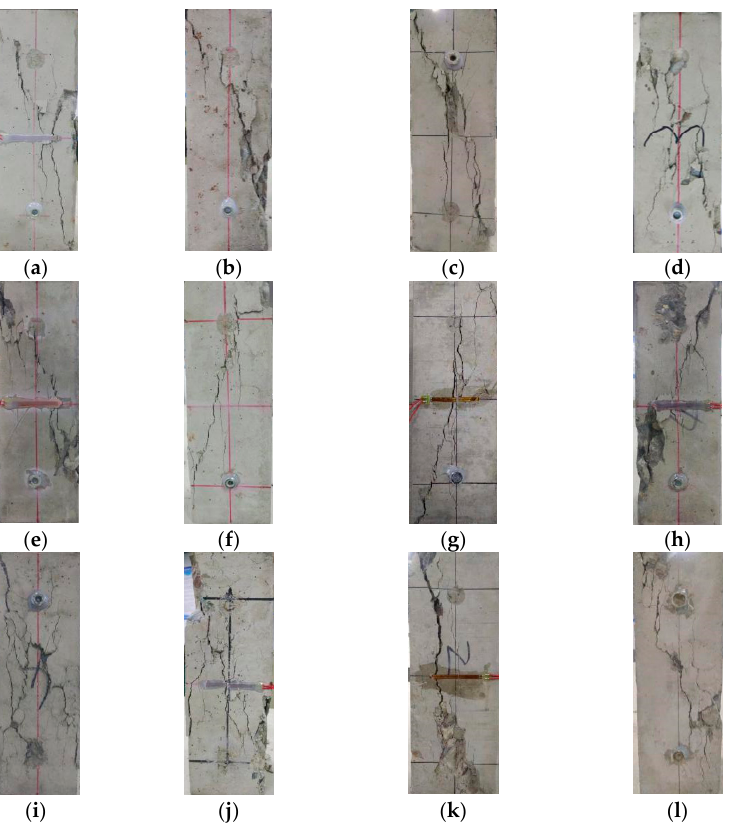
Figure 9. Failure patterns of NAC and RAC specimens after carbonation: ( a ) NC-1, ( b ) NC-2, ( c ) NC-3, ( d ) NC-4, ( e ) RC60-1, ( f ) RC60-2, ( g ) RC60-3, ( h ) RC60-4, ( i ) RC100-1, ( j ) RC100-2, ( k ) RC100-3 and ( l ) RC100-4.